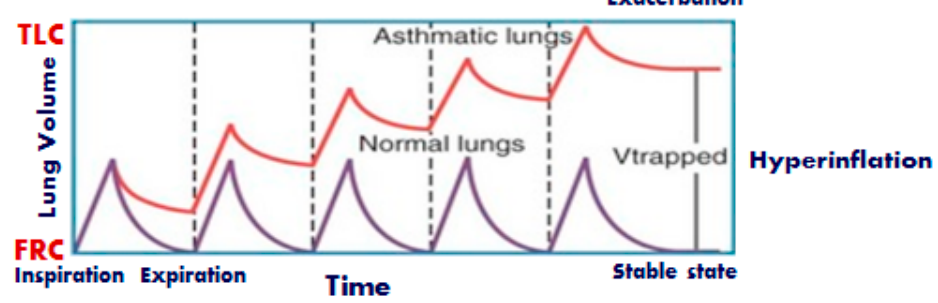
Figure 5. Dynamic hyperinflation during exacerbation.